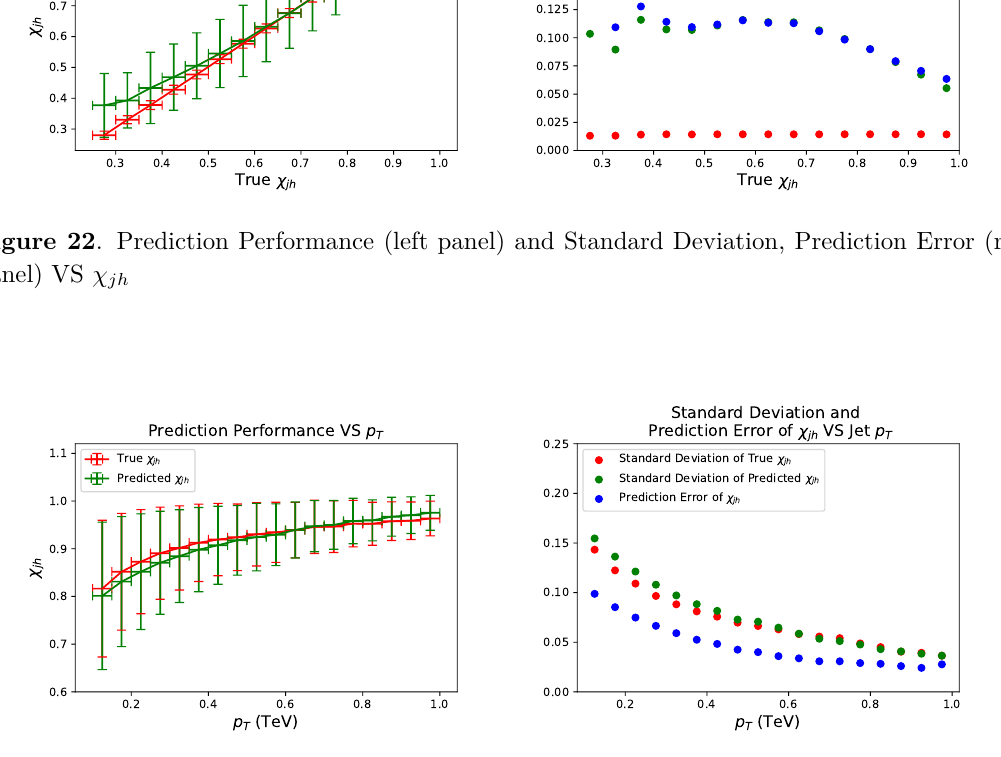
Figure 23 . Prediction Performance (left panel) and Standard Deviation, Prediction Error (right panel) VS Jet p . T